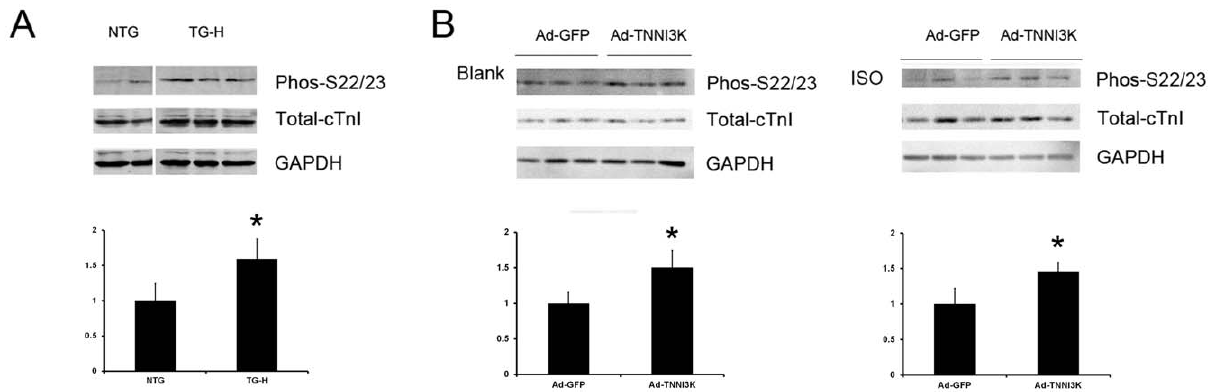
Figure 8. TNNI3K induced cTnI phosphorylation at Ser22/Ser23 invivo and invitro . (A), Heart lysates of TG-H and NTG mice were immunoblotted with antibodies against total and phosphorylated cTnI. TNNI3K induced cardiac troponin I phosphorylation at Ser22/Ser23 in vivo . (B), TNNI3K-induced cTnI phosphorylation at Ser22/Ser23 in cardiomyocytes on the basal and isoproterenol-stimulated level. Immunoblots are representative of 3 independent experiments. *: P , 0.05 vs control group.